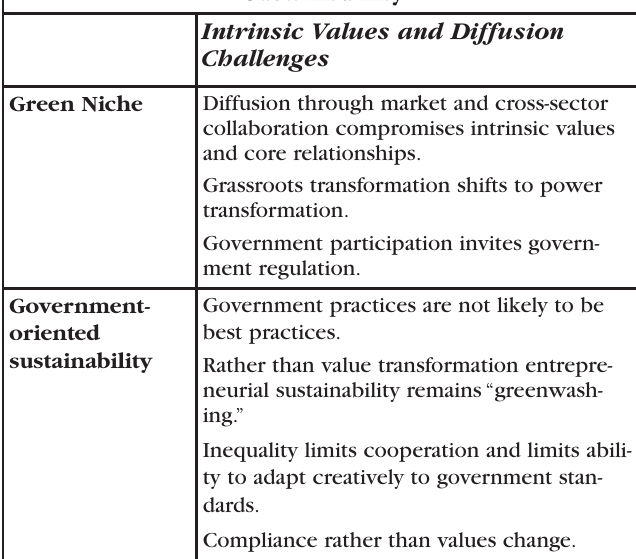
Table 4. Challenges of